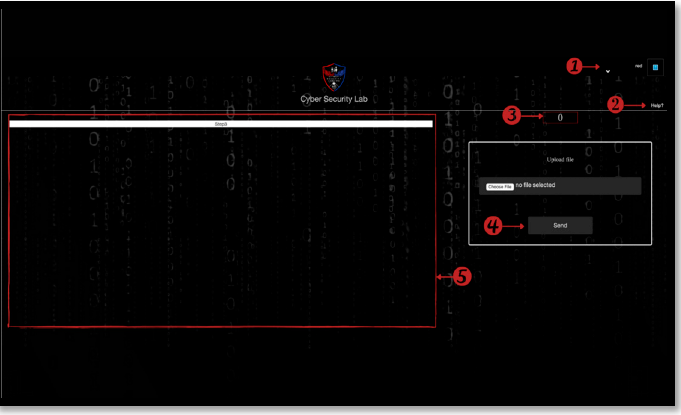
Figure 5. An example of the red team’s login page.